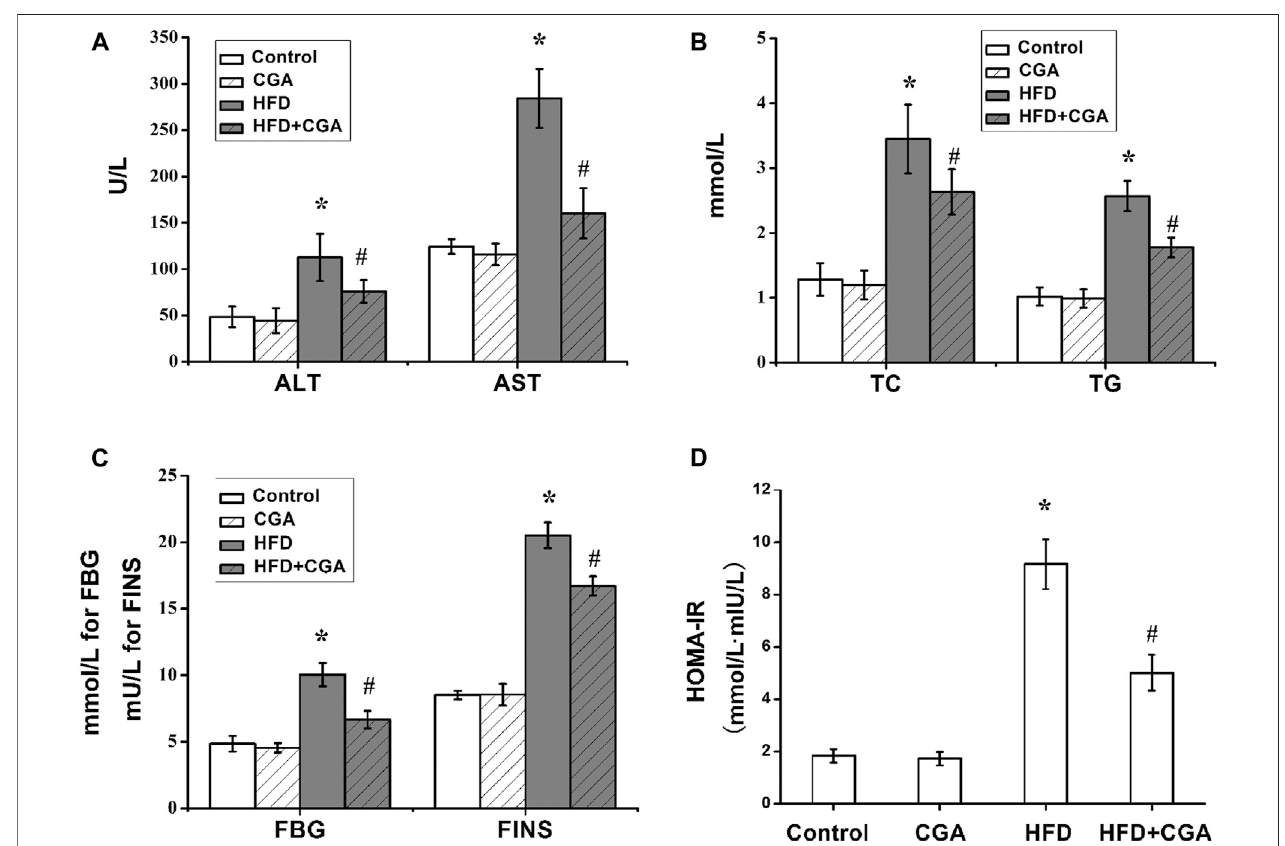
FIGURE 2 | Effect of CGA on serum transaminase, fasting blood glucose (FBG) and blood lipids and insulin resistance. (A) serum transaminase; (B) blood lipids including total cholesterol (TC) and triglyceride (TG); (C) FBGand FINS; (D) HOMA-IR. Dataare presented as mean ± SD. * p < 0.05 as compared with the control group; # p < 0.05 as compared with the HFD